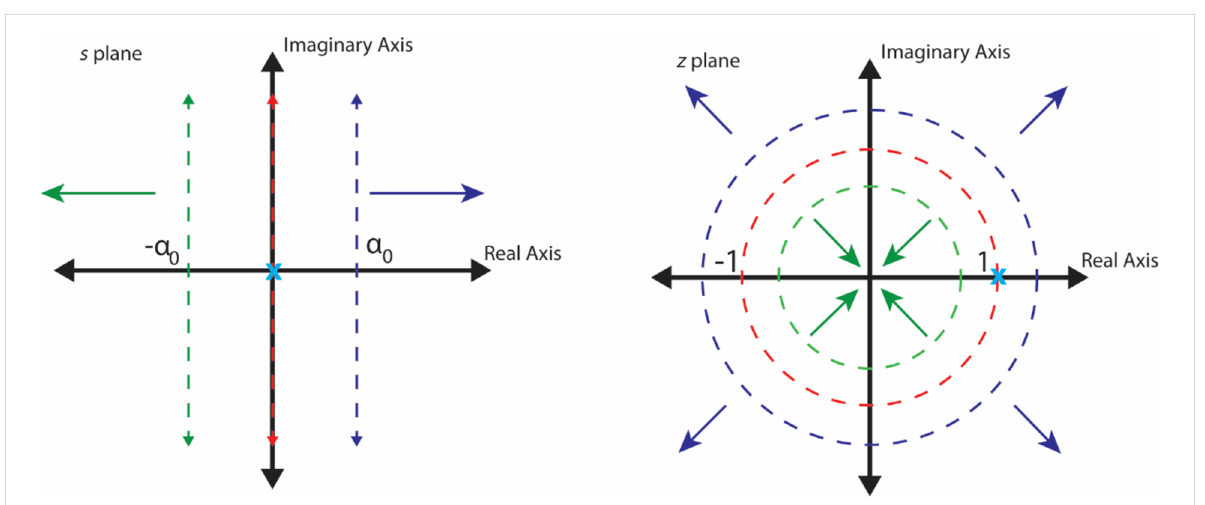
Figure 3: Comparison of the s -plane and the z -plane. Vertical lines on the s -plane map to circles on the z-plane. The imaginary axis on the s -plane, which corresponds to the Fourier transform of the signal, corresponds to the unit circle on the z -plane. Other lines parallel to the imaginary axis on the s -plane correspond to non-unit circles on the z -plane. Circles on the z -plane, other than the unit circle, correspond to discrete modified Fourier trans- forms. The z -domain can be thought of as an infinite collection of modified Fourier transform domains, along with the Fourier transform domain (unit circle), stitched